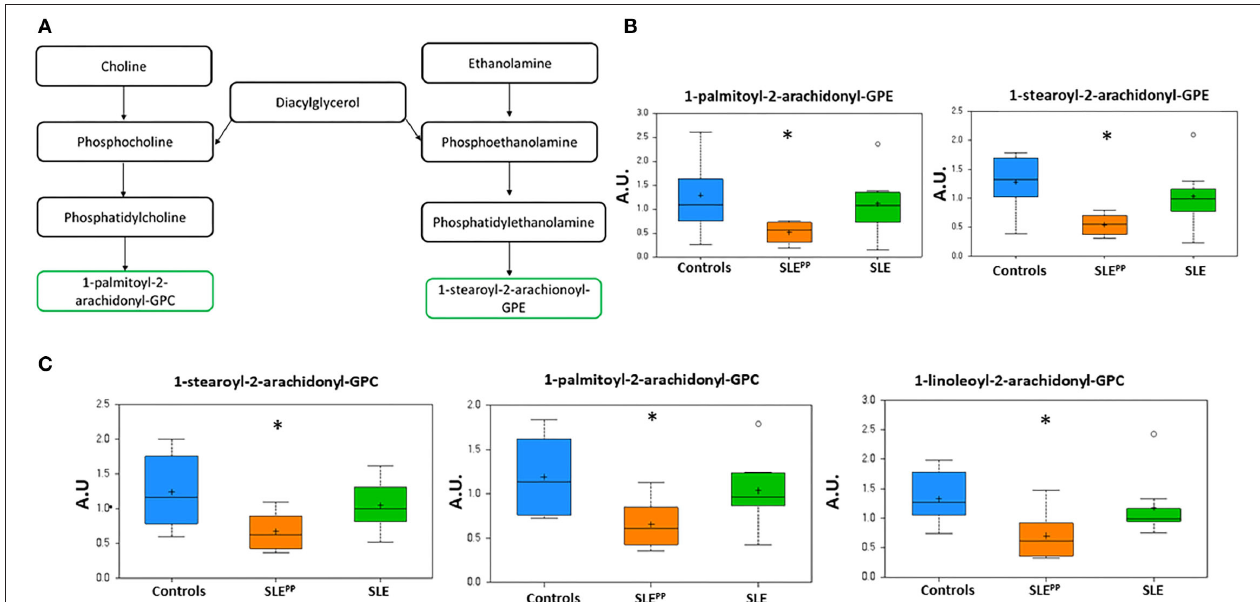
FIGURE 4 | Phospholipids with 2-arachidonoyl acyl chains are reduced in SLE PP serum. Phospholipid derivatives of diacylglycerol (A) were found to be reduced in SLE PP serum samples as compared to SLE and non-SLE control samples. Some of the most discriminatory phospholipids are plotted in arbitrary units (AU), including the GPEs (B) and GPCs (C) highlighting the reduction in SLE, and the even more pronounced reduction in SLE PP . Indeed, these same metabolites were also highlighted as the most discriminatory metabolites for distinguishing SLE PP from SLE by Random Forest analysis ( Figure 2B ). Baseline serum concentrations from 8 non-SLE controls are indicated in blue, 9 patients who exhibited plaque progression in orange, and 8 control SLE patients in green. Sera from SLE PP patients contained significantly ( p < 0.05) less 1-palmitoyl-2-arachidonoyl-GPE, 1-stearoyl-2-arachidonoyl-GPE, 1-stearoyl-2-arachidonoyl-GPC, 1-palmitoyl-2-arachidonoyl-GPC, and 1-linoleoyl-2-arachidonoyl-GPC than non-SLE controls and control SLE counterparts. Metabolite comparisons between groups were carried out using a Welch’s adjusted unequal variance t- test. * indicates p <